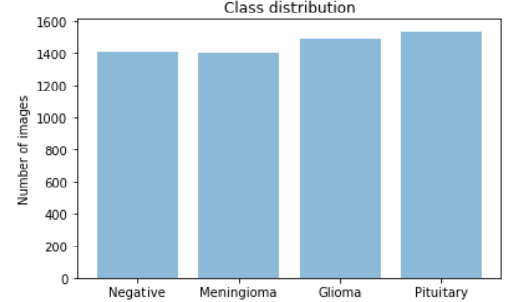
Figure 5. Uniform Class Distribution of Brain Tumor Images after dataset has been pipelined to the Augmentor